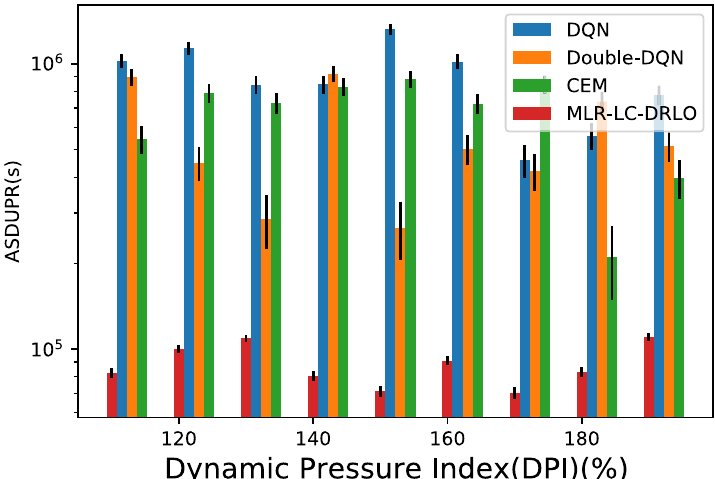
Fig. 6 Adaptation time spent on retraining after workload changes between MLR-LC-DRLO and other fine-tuned RL-based approaches: with the same amount of DPI, MLR-LC-DRLO spend less time to recover offloading